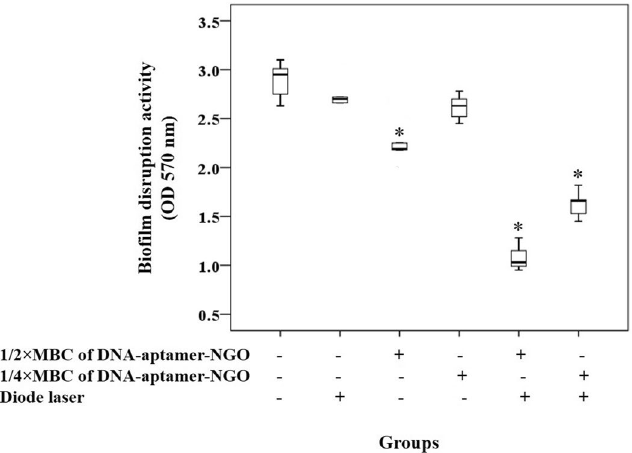
Figure 12. The anti-biofilm effects of different treatment groups against P. gingivalis . Biofilm disruption of P. gingivalis following treatment with 1/2 × and 1/4 × MIC of DNA-aptamer-NGO, aPDT (DNA-aptamer-NGO at 1/2 × and 1/4 × MIC plus diode laser), and diode laser were determined by crystal violet assay. Significant differences according to the control, * P <